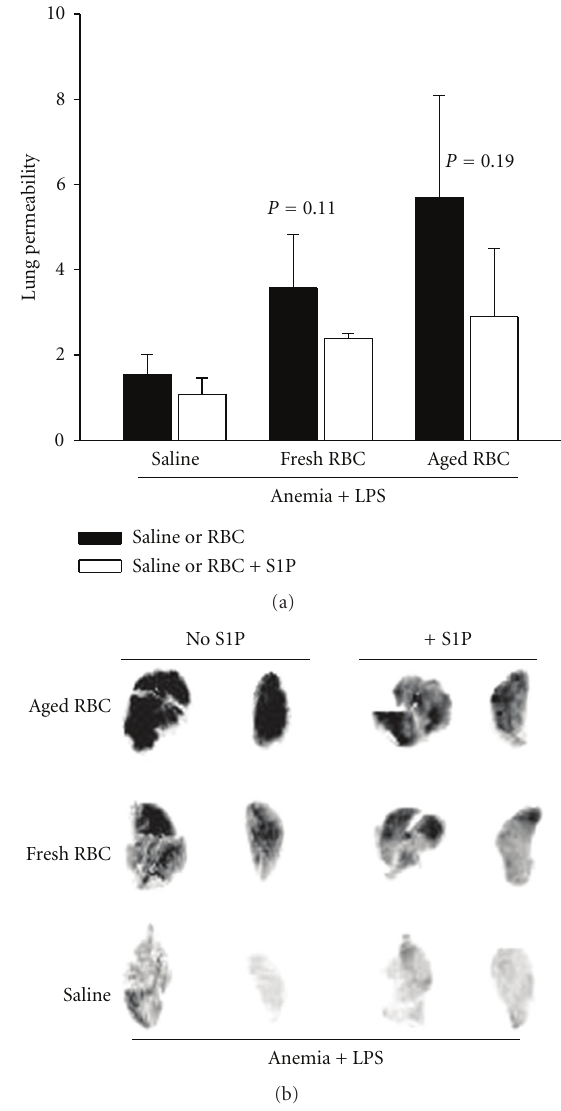
Figure 4: E ff ect of transfusion of S1P-loaded fresh and aged RBC on lung endothelial permeability . Twentyfour hours after major blood loss (0.02mL/gm), mice were treated with LPS. Four hours after LPS treatment, fresh or aged RBCs with or without a preload with SIP (RBC + S1P) were transfused. (a) Evans blue dye (EBD) in the intact lung quantified and (b) representative images of the dye in the lungs demonstrated. Results were analyzed by one-way ANOVA (Bonferroni correction); ∗ P < 0 . 05 versus